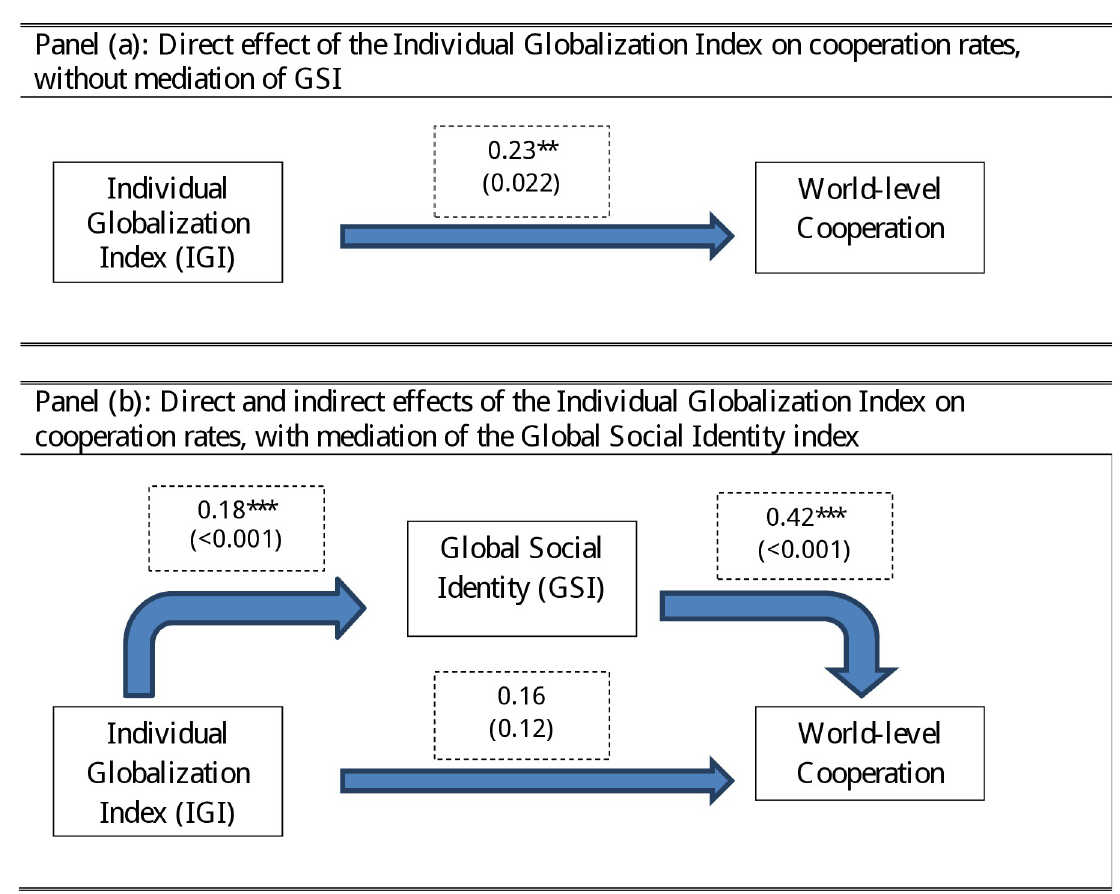
Fig 1. Mediating effect of global social identity between individual involvement with globalization, as measured by the IGI, and propensity to cooperate at global level. The values in the dashed-contour boxes are the coefficients, expressed in units of standard deviation, estimated in an OLS econometric analysis using the same models as in Table 2. The number in parenthesis is the p-value of the test that the coefficient is equal to zero. The stars denote the level of significance of the rejection of the null hypothesis ( � = p < 0.1; �� = p < 0.05; ��� = p < 0.01). Panel (a) reports coefficients for the model that does not include GSI as covariate (corresponding to Table 2: column 1); Panel (b) reports coefficients for the models including GSI as covariate (corresponding to Table 2: column 2 and 3). Fig 1 reports coefficients based on the OLS estimation that has been used for the Sobel-Goodman mediation test reported in Table 3, column 1.